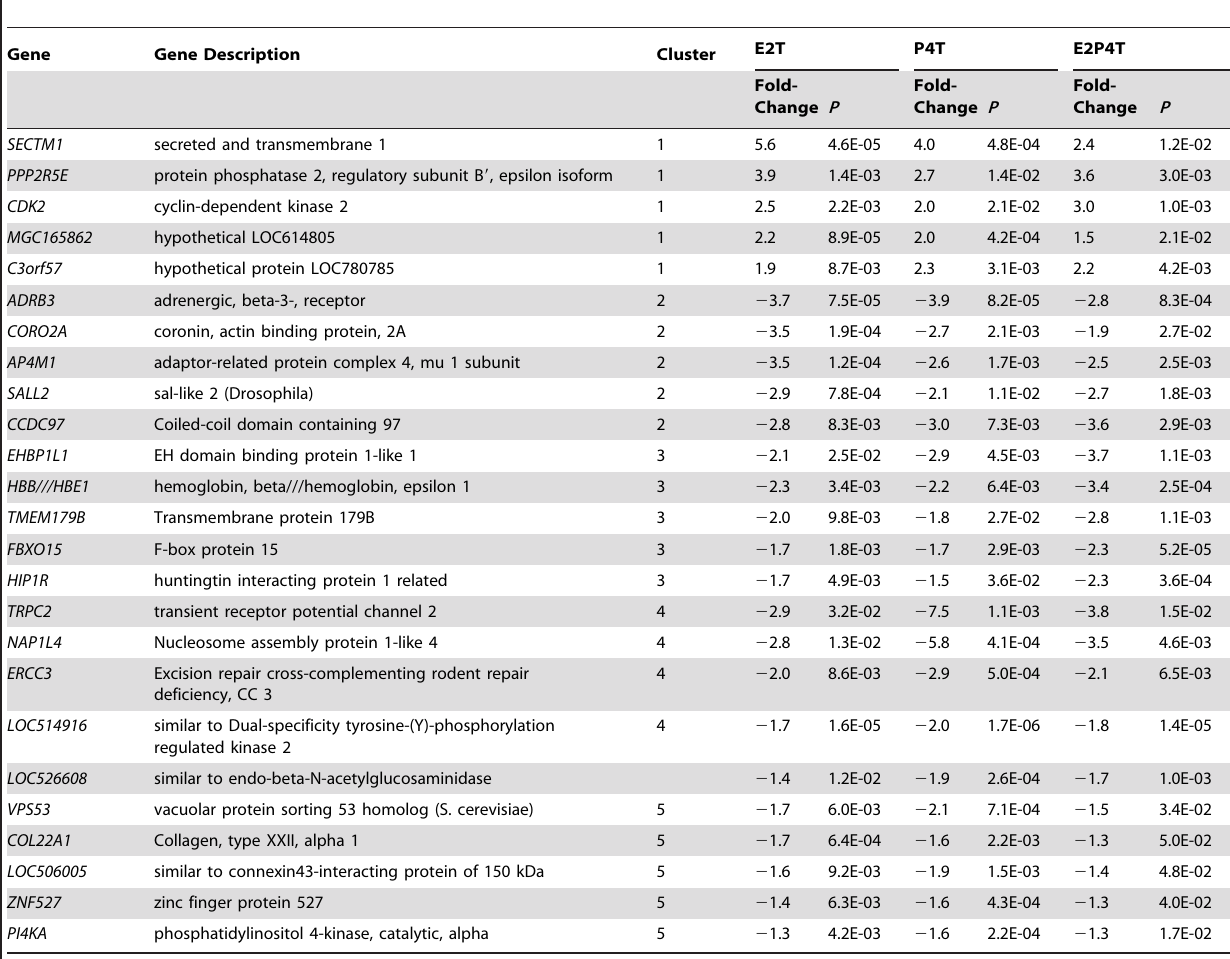
Table 1. Examples of genes significantly regulated by estradiol-17 b (E2T), progesterone (P4T) and estradiol-17 b + progesterone (E2P4T) treatment, grouped in 5 distinct